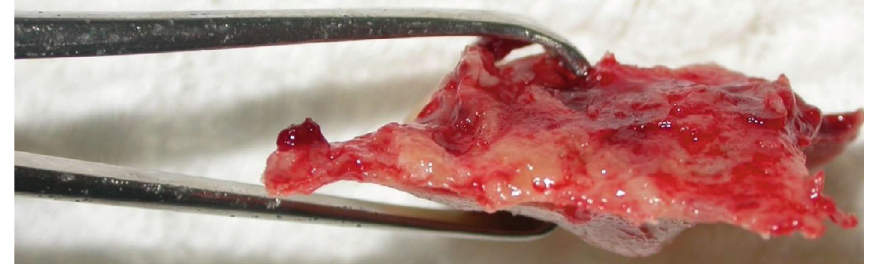
Figure 3: Super-inferior view of the premaxilla alveolar